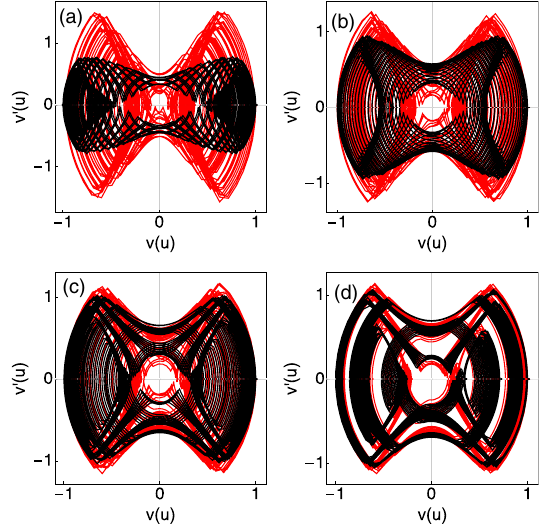
FIG. 4. Phase trajectories of a first particle (black) and second particle (red). Parameters for the calculation are: Panel (a) Φ 1 ¼ 0 . 227 π , w ð s Þ / K ¼ 0.178, f ð s Þ ¼ 0 . 653 ; Panel (b) Φ 1 ¼ 0 . 389 π , w ð s Þ / K ¼ 0.165, f ð s Þ ¼ 0 . 431 ; Panel (c) Φ w ð s Þ / K ¼ 0.132, f ð s Þ ¼ 0 . 27 ; Panel (d) Φ 1 ¼ 0 . 615 π , w ð s Þ / K ¼ 0 . 102 , f ð s Þ ¼ 0 . 18 . Initial conditions for both particles for all panels are v 01 ¼ 1 and v 0 01 ¼ 0 .